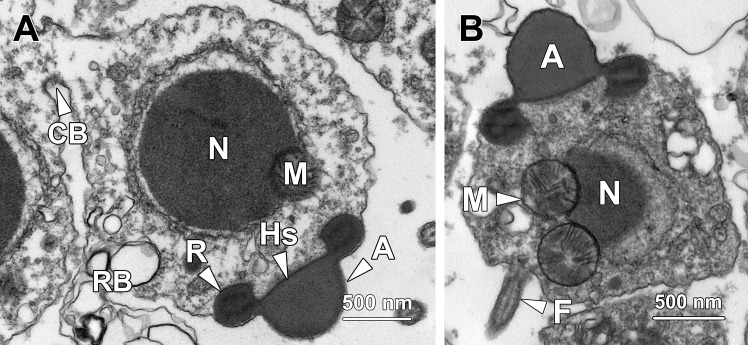
Transmission electron micrographs of step 9 spermatids.(A) Step 9 spermatids are still in pairs and interconnected by a cytoplasmic bridge (CB). The central hemisphere (Hs) in the acrosome occupies the entire acrosomal matrix and connects to the ring-like structure (R) on both sides. The whole acrosome exhibits an identical electron density except for the darker particles lining the interior border of the ring structure. Multiple irregular-shaped residual bodies (RB) containing excess cytoplasm appear in step 9 spermatids. M, mitochondria; N, nucleus. (B) In step 9 spermatids, the acrosome (A) starts to migrate towards the anterior end of the cytoplasm, which is opposite to the pole where the flagellum (F) and mitochondria (M) reside. The mitochondria remain firmly adherent to depressions at the posterior end of the nucleus (N).